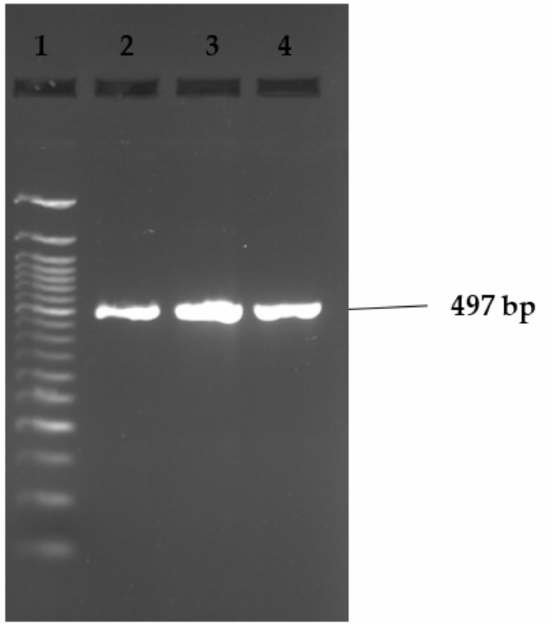
Figure 3. Image showing example of hilA gene amplicons observed on agarose gel. Lane 1 contains the 50 bp DNA ladder and lanes 2–4 show positive results for the hilA gene (497 bp). Lanes 2 and 3 contained amplicons for S. Stanley isolates, while lane 4 contained S.